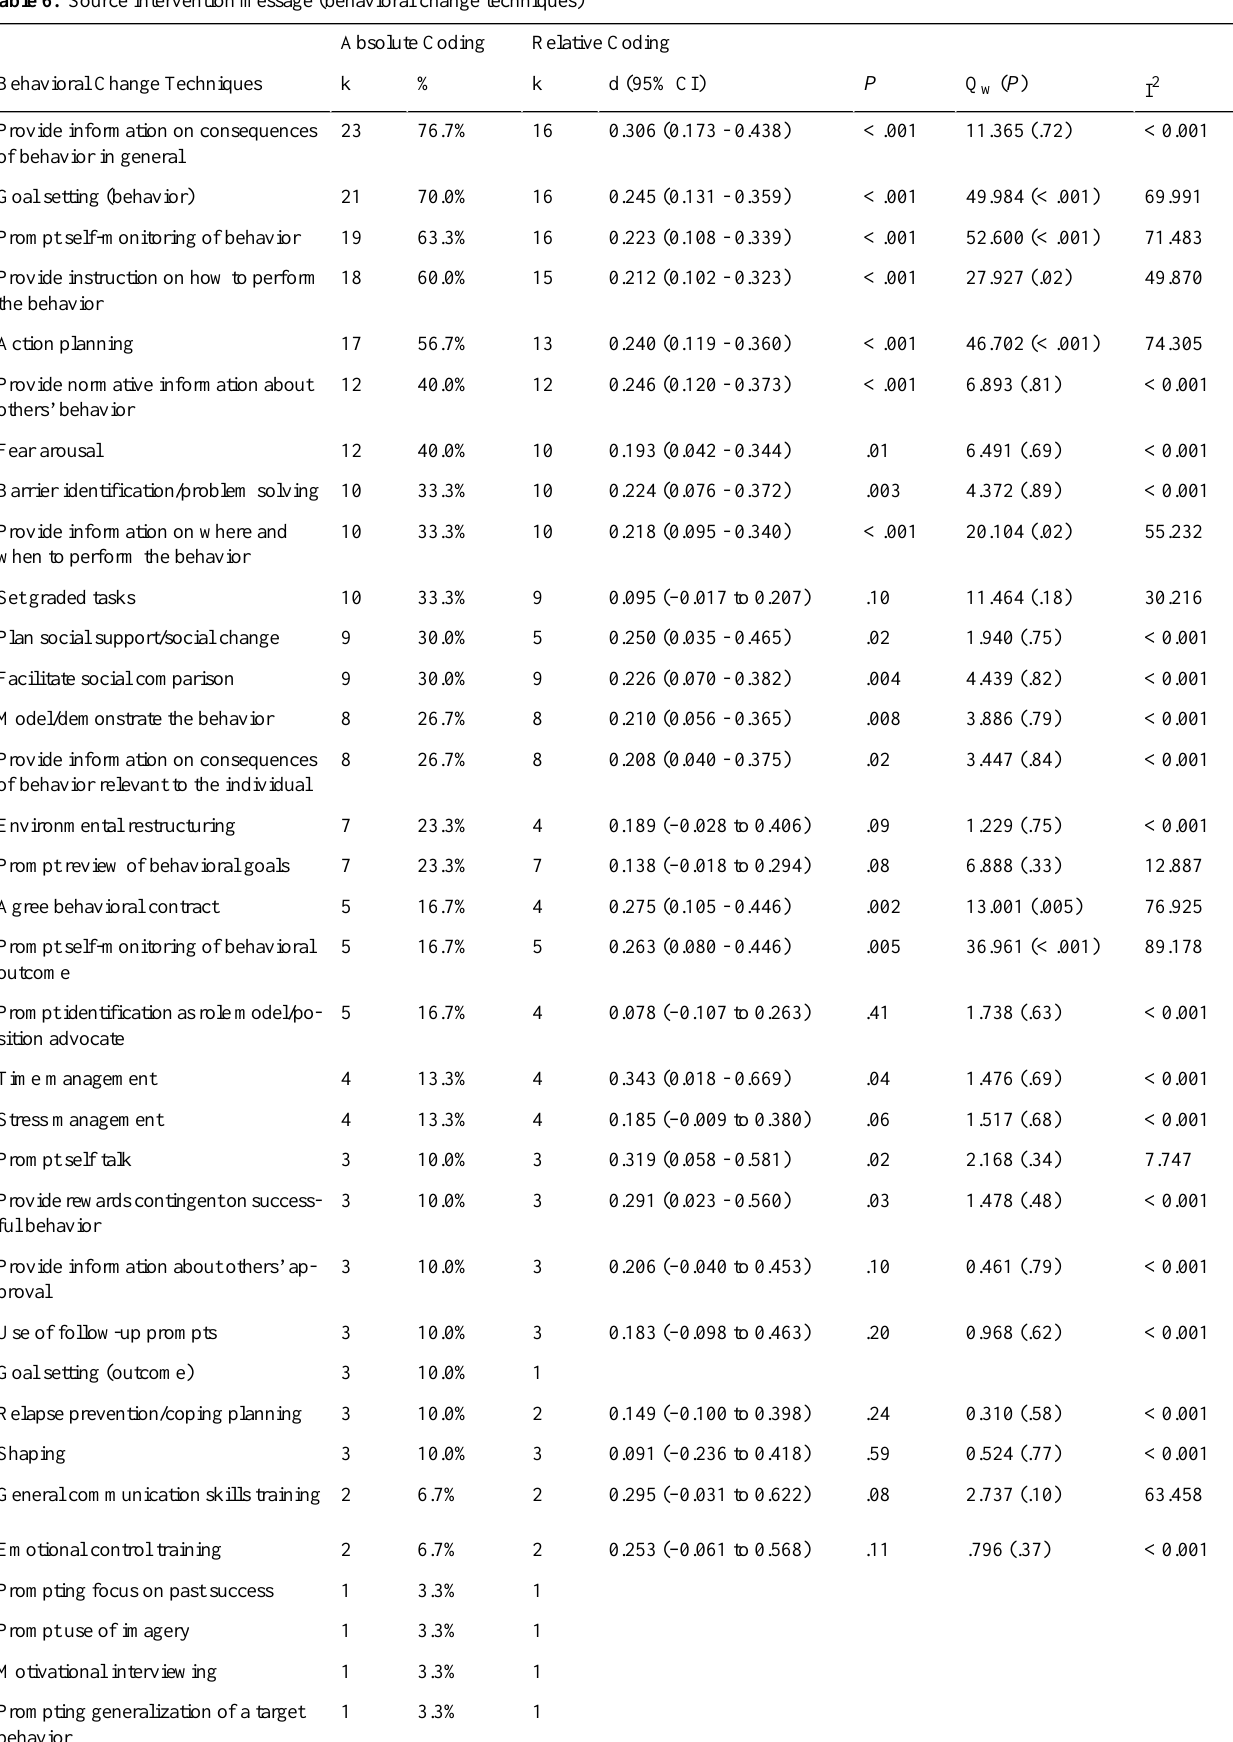
Table 6. Source intervention message (behavioral change techniques)